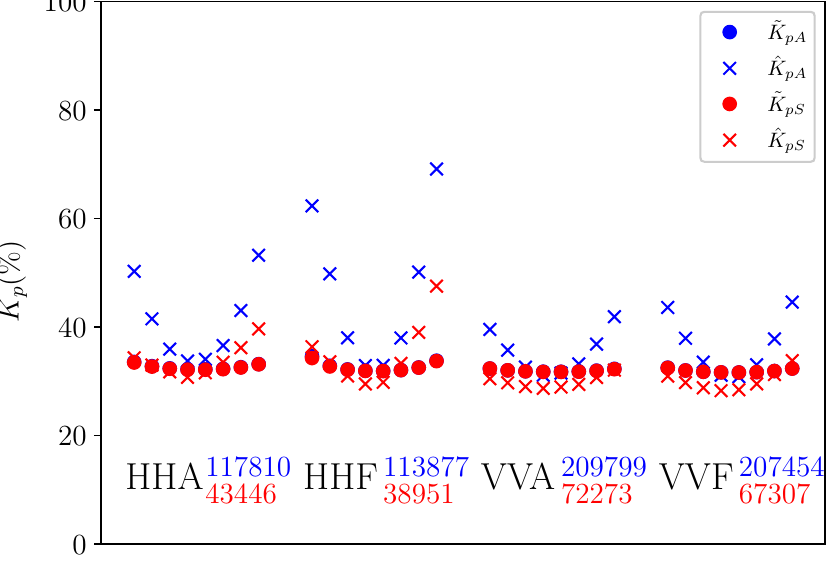
Figure 7. The red (blue) circles represent the median of product K p s ( K MED p ) on sea (all types of surfaces) as a function of the slice index for each of the four flavors (pol; view) , and for the σ 0 level corresponding approximately to 15 ms − 1 . Estimates of K p ( K EMP p ) are depicted with crosses with the same color code. The total number of samples is reported by the flavor with the same color code. The 3-character strings in the panel represent the following: HH (VV) stands for HH-Pol (VV-Pol) and A (F) stands for aft